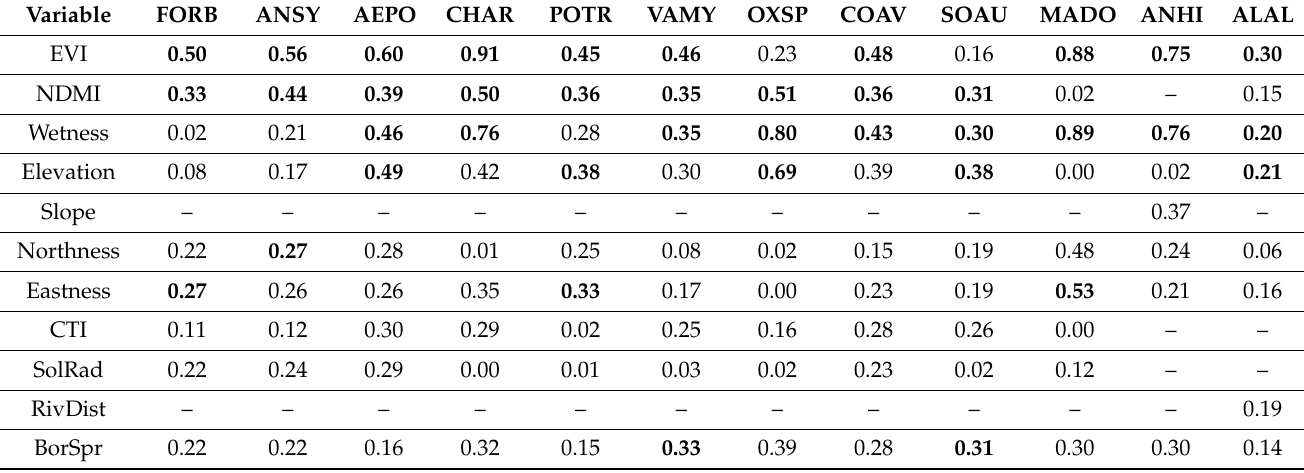
Table A2. Jackknife test for variable importance after removing one variable at a time for 14 food- probability models for the brown bear in the Central Forest State Nature Reserve (West-European Russia) in 2008–2020 using the metric TSS with running the test for one single variable. The first four most important variables are marked in bold. Variable abbreviations are the same as in Table